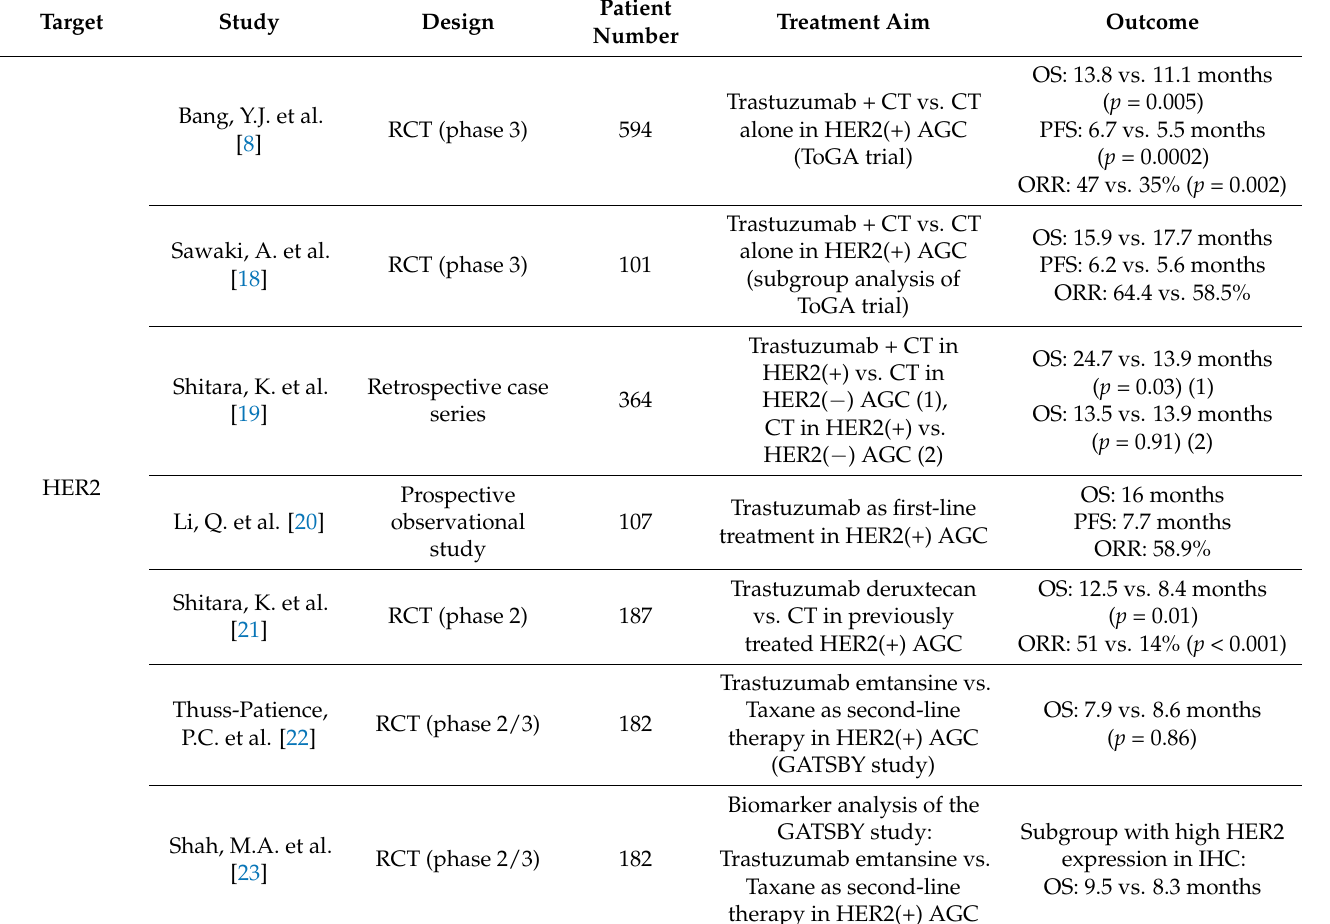
Table 1. Targeted therapies and treatment